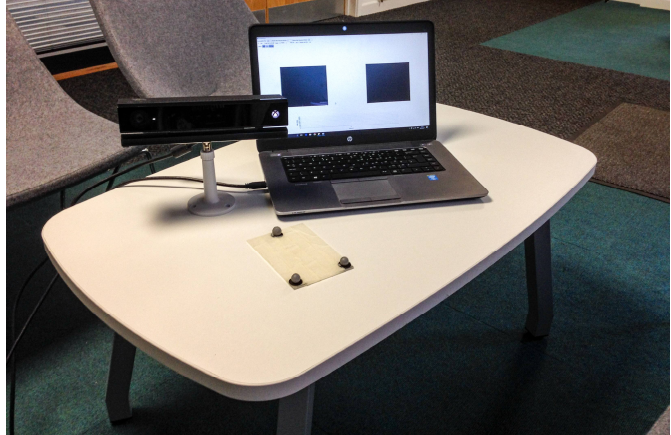
Figure 4. Low-cost, automatic and simple-to-use system for home-based gait analysis. System comprises a Microsoft Xbox One Kinect, laptop (analysis software) and retro-reflective marker